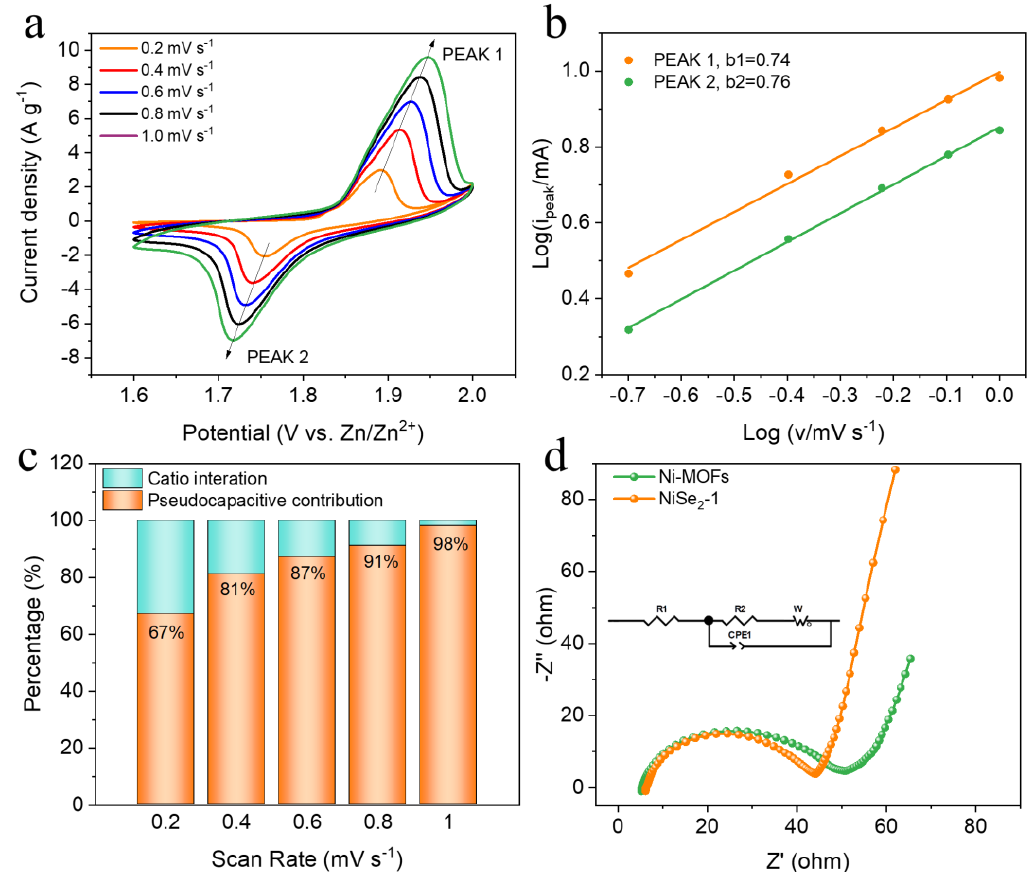
Figure 4. ( a ) CV scans of NiSe 2 − 1 at various rates. ( b ) Correspondingly fitted b -value at respective redox peaks. ( c ) Relative contribution of the capacitive and diffusion-controlled charge storage at different scan rates. ( d ) Nyquist plots of Ni-MOFs and NiSe 2 − 1.